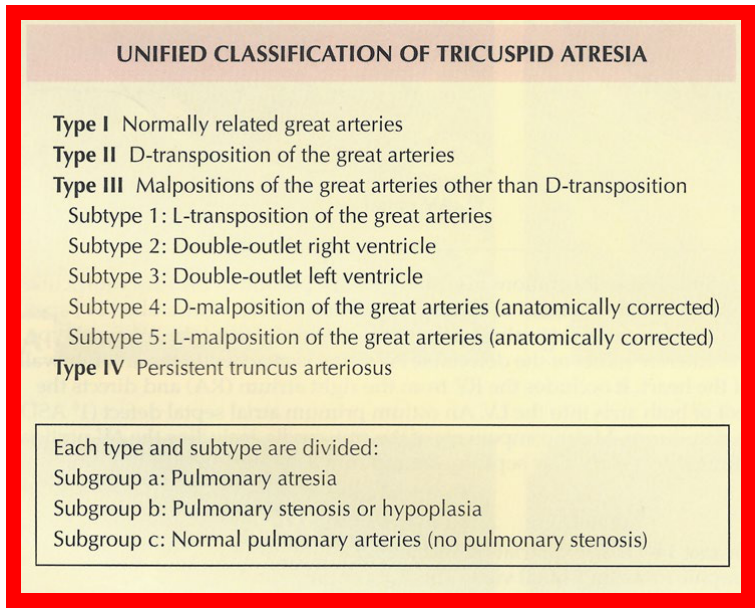
Figure 2. Classification of Tricuspid Atresia. Reproduced from [12].